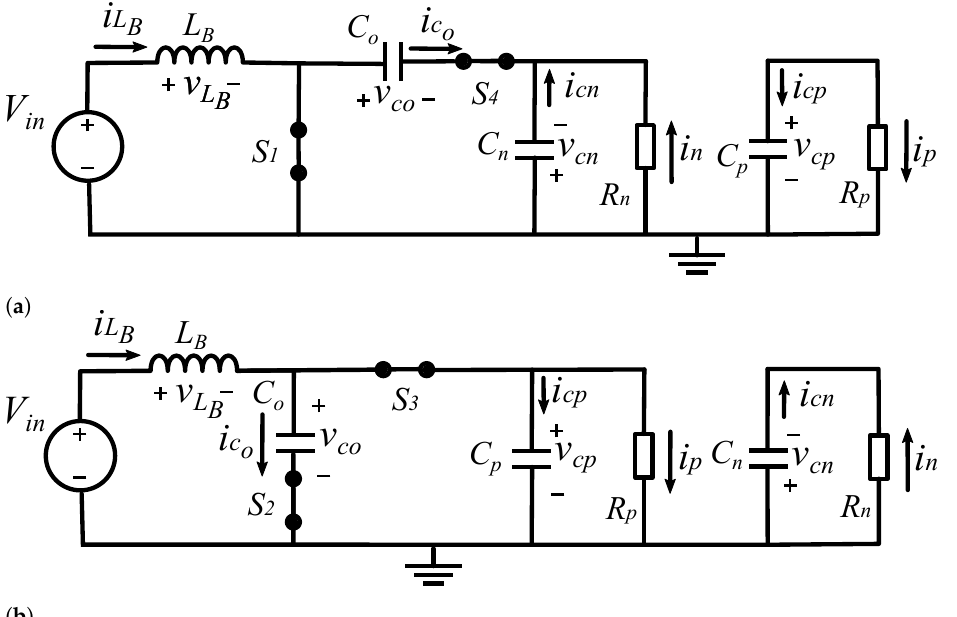
Figure 4. Equivalent circuits of the converter in steady-state. ( a ) Interval 1: 0 < t < DT s ; ( b ) Interval 2: DT s < t < T s